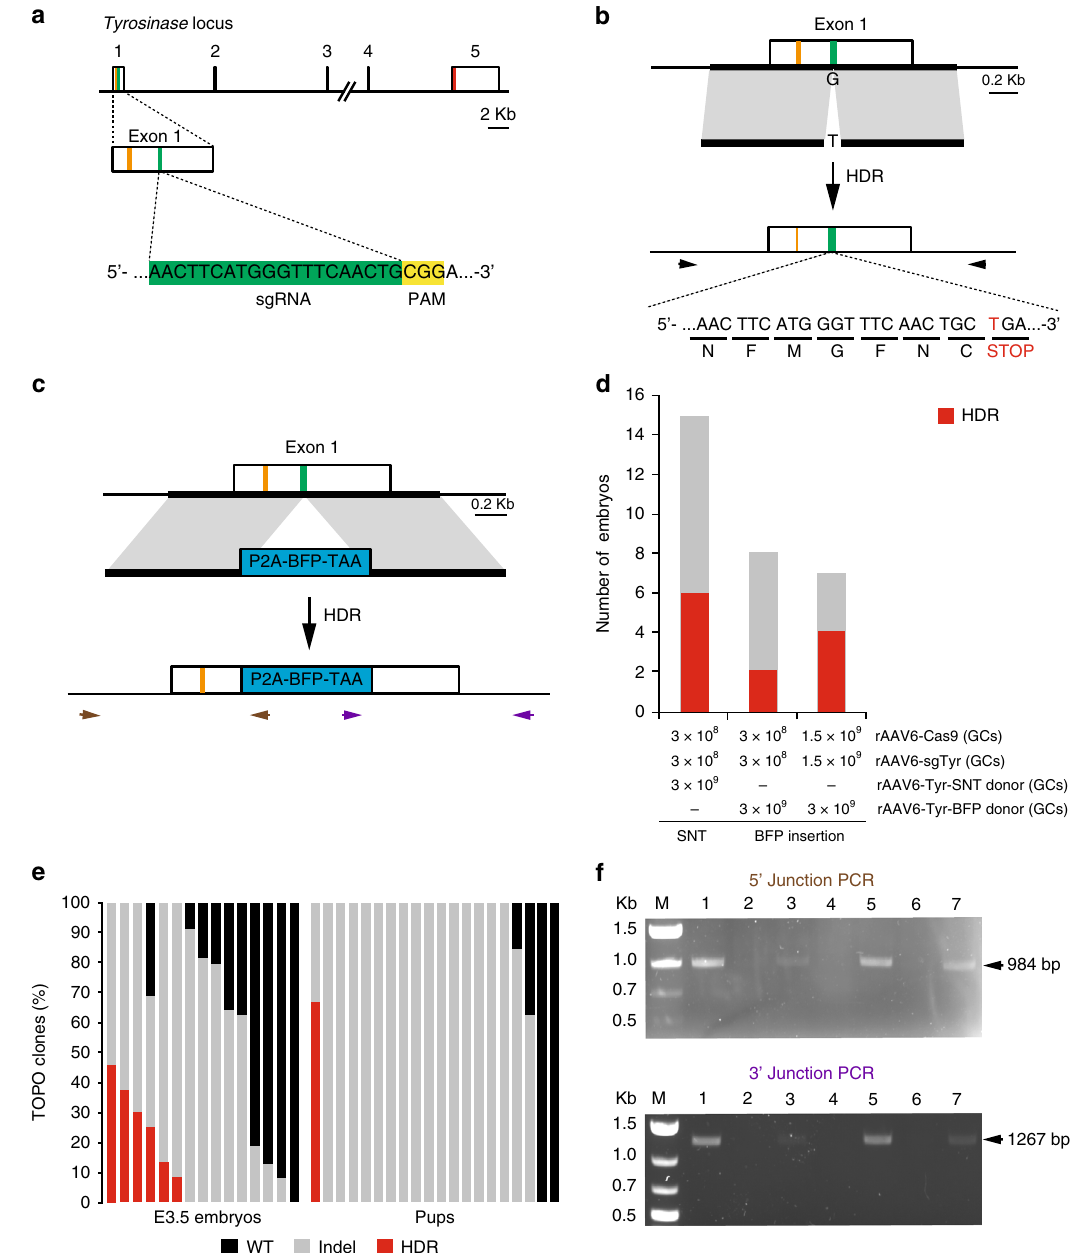
Fig. 3 Recombinant AAV vectors can mediate homology-directed repair (HDR). a Schematic representation of the Tyr locus and location of sgRNA in exon 1. The orange and red lines mark the initiation and termination codons respectively. The green line indicates the location of the sgRNA used to target Tyr . b Strategy to introduce a premature stop codon in the Tyr locus using HDR. The 5 ′ and 3 ′ homology arms are marked by a thick line. A G to T nucleotide transversion in the PAM sequence converts a glycine codon (GGA) into a stop codon (TGA) disrupting translation of Tyr . Arrows indicate binding sites of the primers used in PCR-TOPO sequencing. c Strategy to insert the blue fl uorescent protein (BFP) gene into the Tyr locus using HDR. Brown and purple arrows depict the binding sites of PCR primers used to con fi rm the insertion of BFP into Tyr locus. P2A, Porcine teschovirus-1 2A peptide; TAA, Stop codon. d Histogram showing the frequency of single-nucleotide transversion and BFP insertion by HDR using two different mixtures of rAAV vectors. e Analysis of single-nucleotide transversion in individual embryos or pups using PCR-TOPO sequencing. Each bar represents an individual sample. For pups, only DNA from tail snips and ear punches was analyzed. f Con fi rmation of BFP insertion using PCR. Four out of seven E3.5 embryos tested showed correct insertion of BFP into the Tyr locus. The top panel shows ampli fi cation of the 5 ′ -junction of the targeted Tyr locus using a forward primer that binds to genomic DNA upstream of the homology region and a reverse primer that binds to the BFP gene as shown in ( c ). The bottom panel shows ampli fi cation of the 3 ′ -junction of the Tyr- edited allele using a forward primer that binds to the BFP gene and a reverse primer that binds to genomic DNA downstream of the homology